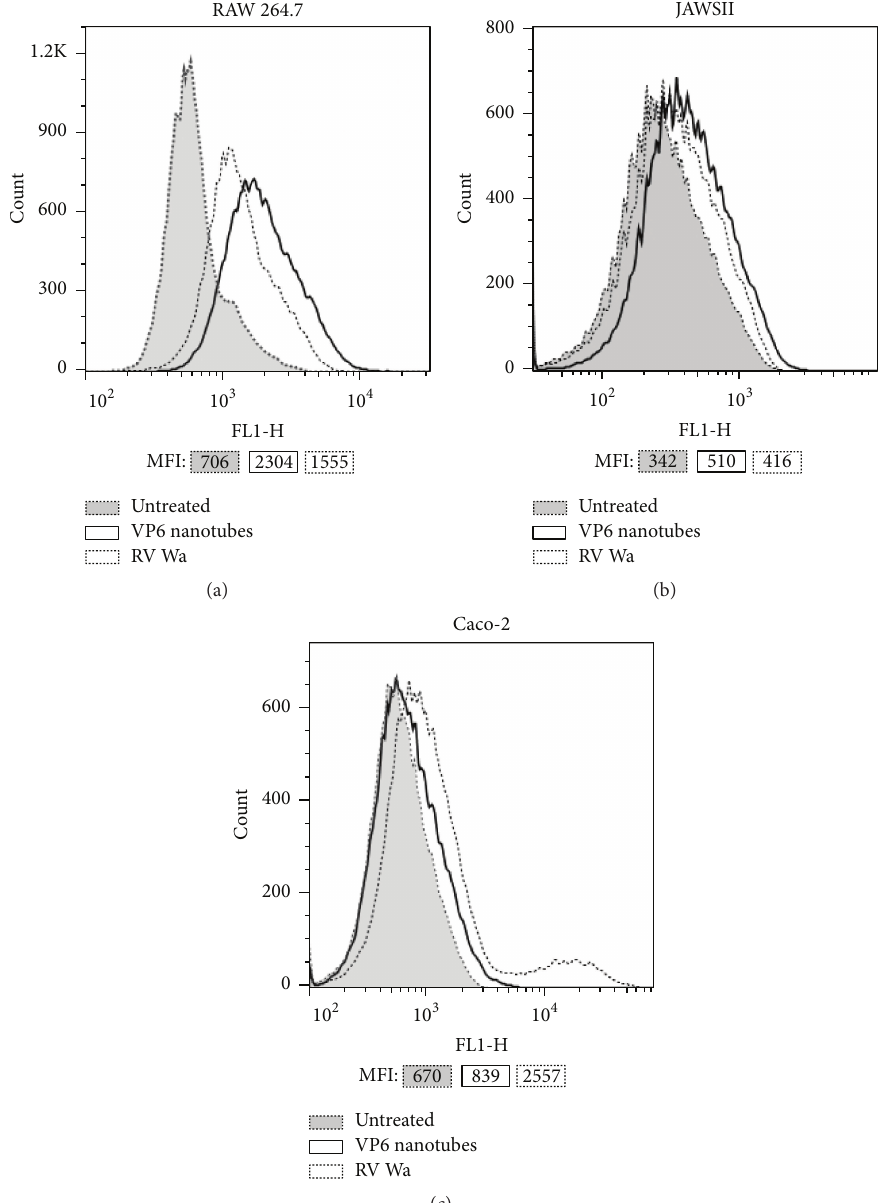
Figure 2: Internalization of VP6 nanotubes. Flow cytometry analysis of VP6 uptake by RAW 264.7 macrophages (a), JAWSII DCs (b), and human colorectal Caco-2 cells (c) after 24 h incubation in the presence of 100 𝜇 g/mL VP6. Cells exposed to rotavirus (RV) Wa and untreated cells incubated in culture medium only served as controls. VP6 was detected by intracellular staining with rabbit anti-rotavirus antibody followed by goat fluorescein isothiocyanate-conjugated anti-rabbit Ig antibody. Shown are overlaid histograms of cells exposed to VP6 nanotubes or RV Wa and untreated cells of one representative experiment of three independent experiments performed. Mean fluorescence intensity (MFI) values of each histogram are